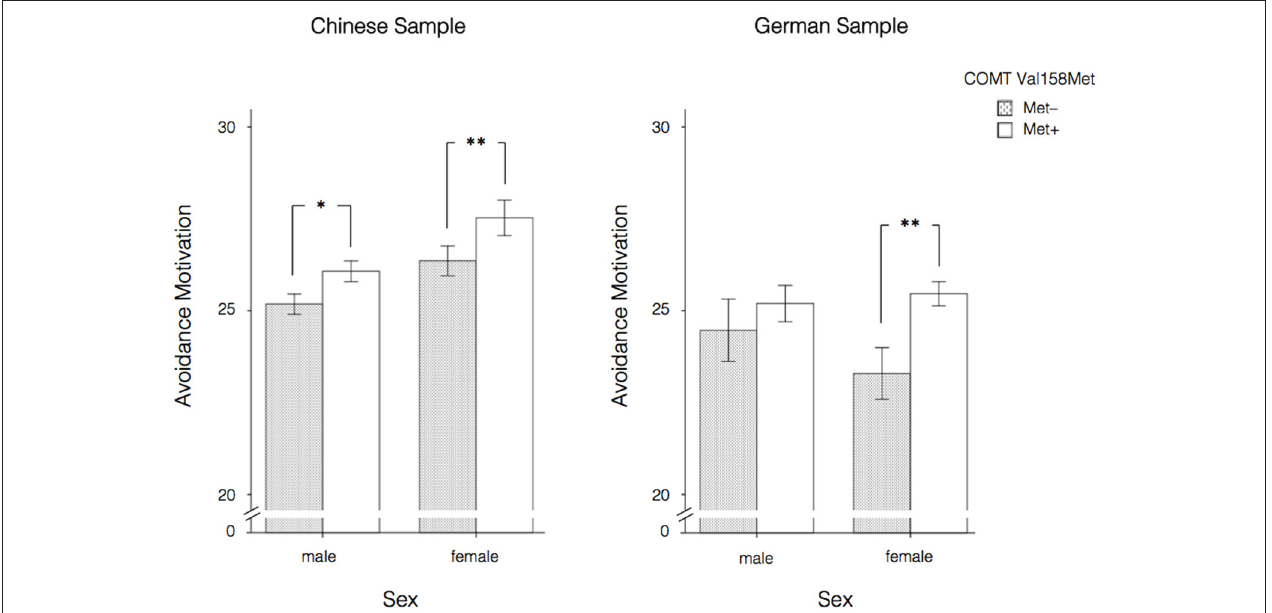
FIGURE 1 | Effects of the COMT Val158Met polymorphism (allele level) on Avoidance Motivation split by nation and gender. Error bars indicate ± 1 SE. * p < 0.05, ** p < 0.01,